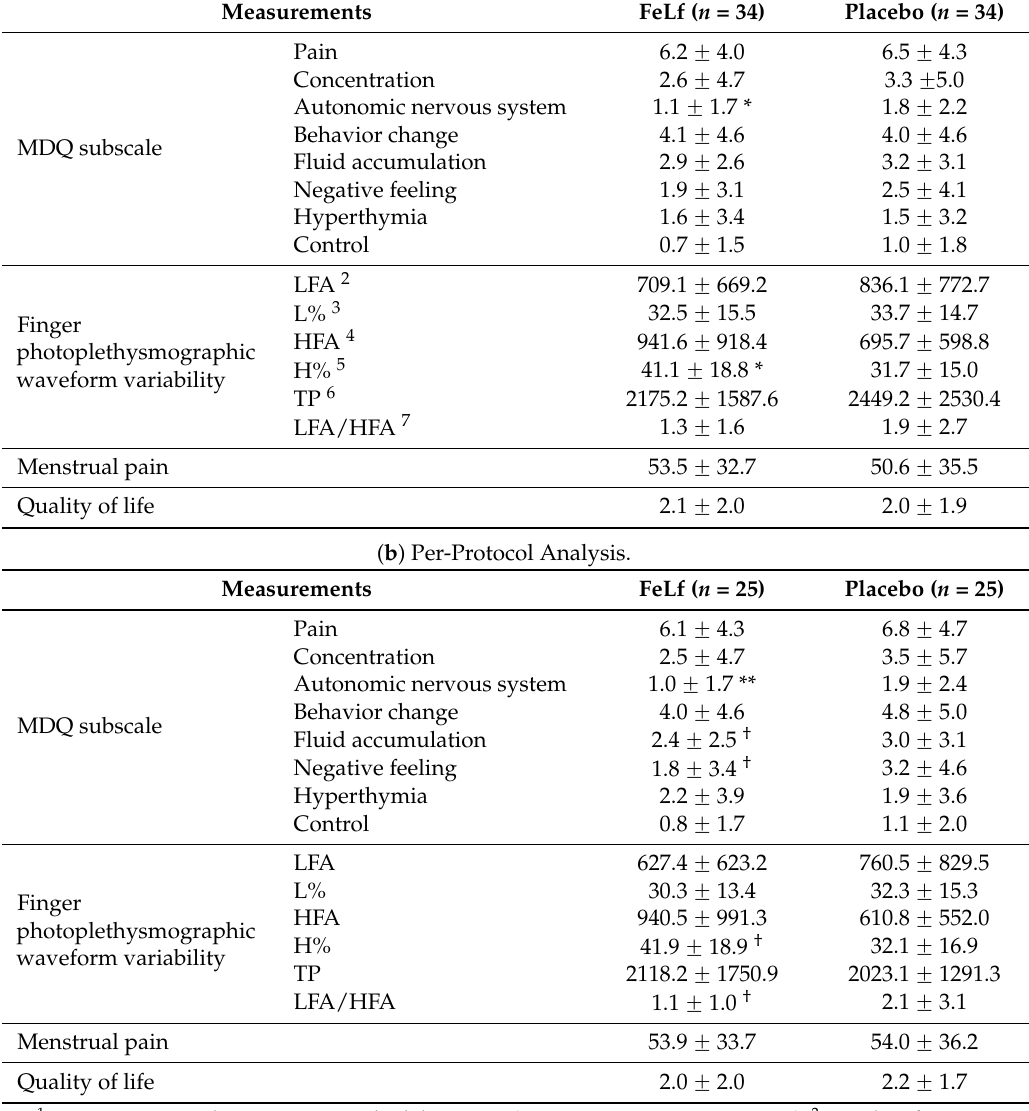
Table 2. Comparison of Moos Menstrual Disorder Questionnaire (MDQ), menstrual pain and quality of life scores and finger photoplethysmographic waveform variability between the iron–lactoferrin complex (FeLf) and placebo groups in the total intention-to-treat cohort ( a ) and in the par-protocol participants administered the study drug for ě 6 days ( b ) 1